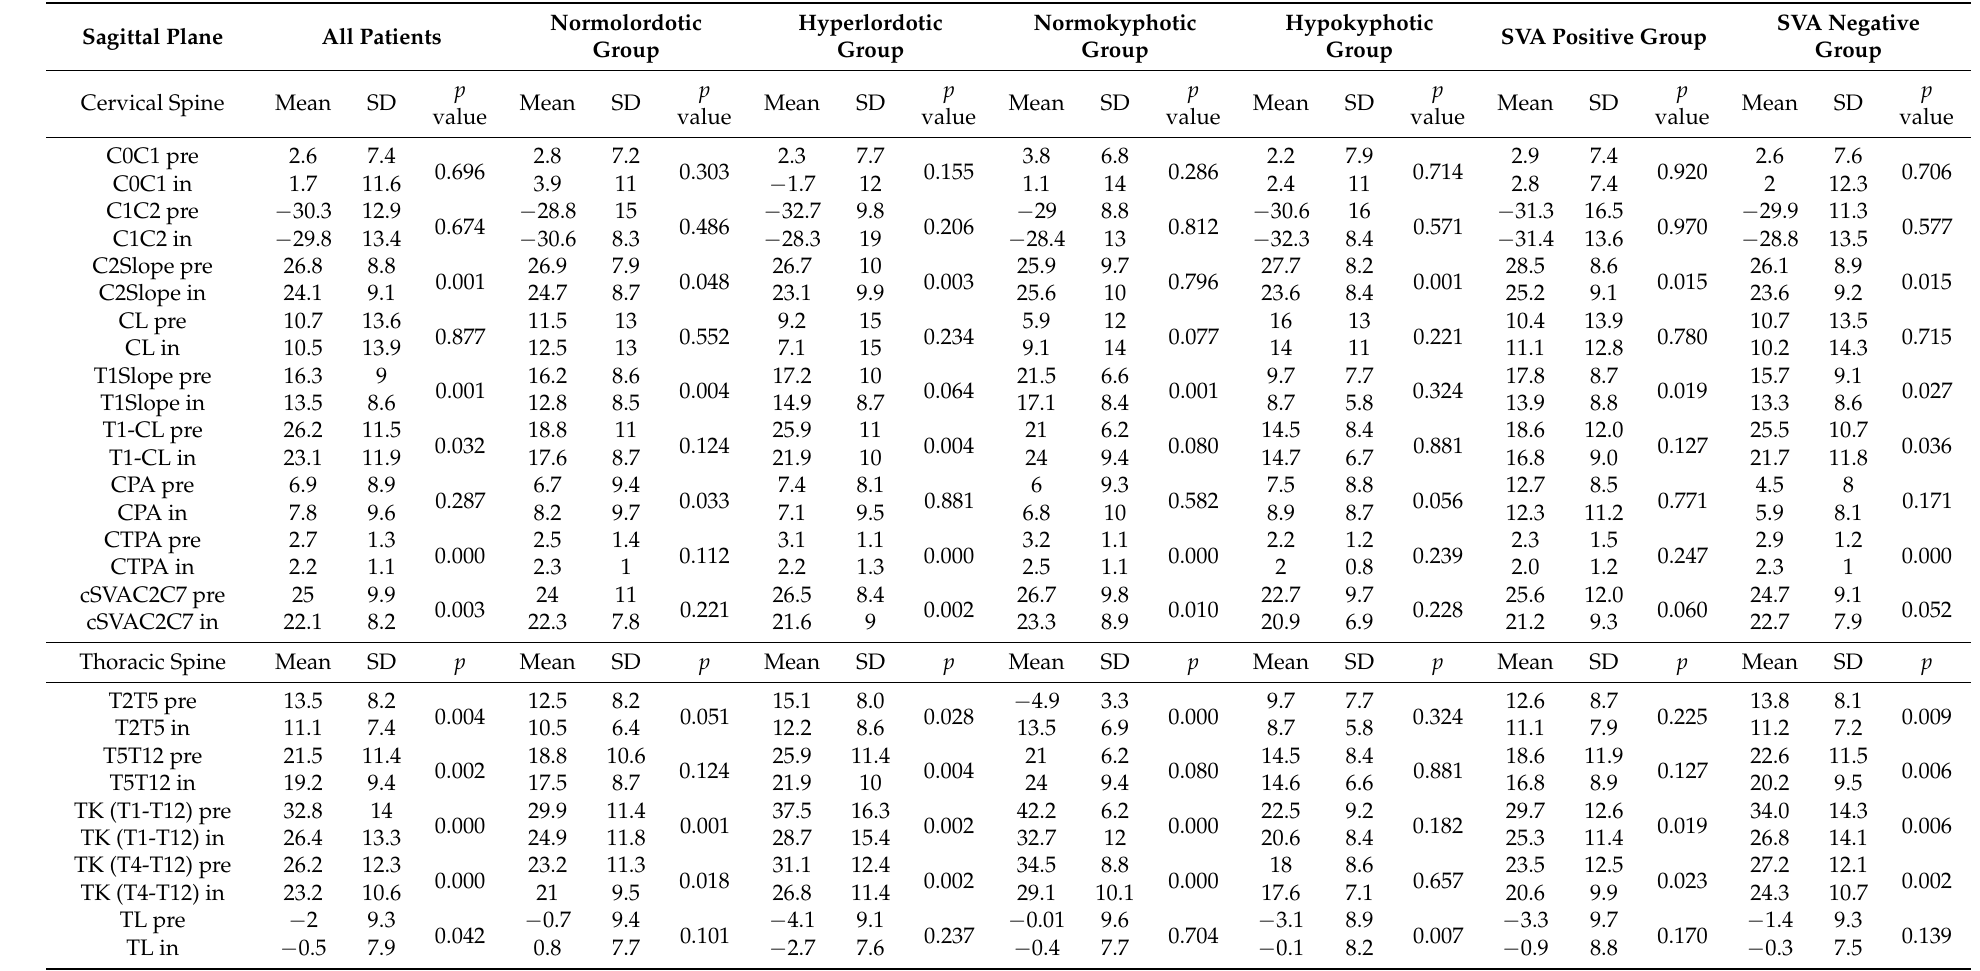
Table 1. Pre- to in-brace changes of sagittal